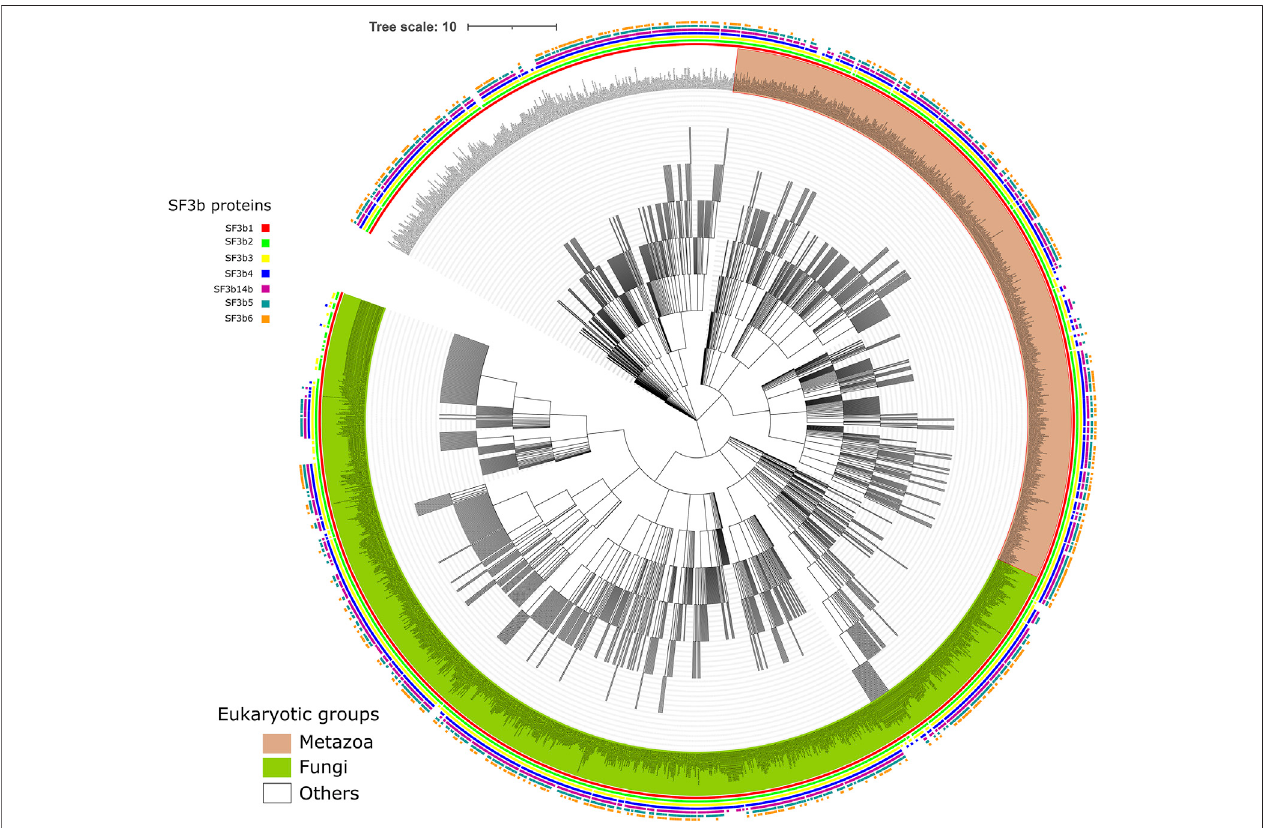
FIGURE1| DistributionofSF3bhomologsacrosseukaryotes.ShownistheNCBIcommontaxonomytreeof2142speciesthathavetherecognizablehomologfor atleastoneofthesevenSF3bproteins.SquareboxesatthenodetipinthetreeindicatethepresenceofhomologsforSF3b1(red),SF3b2(green),SF3b3(yellow),SF3b4 (blue), SF3b14b (maroon), SF3b5 (dark cyan) and SF3b6 (orange). The major clades in the tree namely Metazoa and Fungi are highlighted in light brown and light green background, respectively, for their node labels. The enlarged version of the fi gure with legible labels can be accessed in https://doi.org/10.6084/m9. fi gshare. 16866493.v1.ThespeciestreewasobtainedfromNCBItaxonomydatabase(Schochetal.,2020)andthe fi